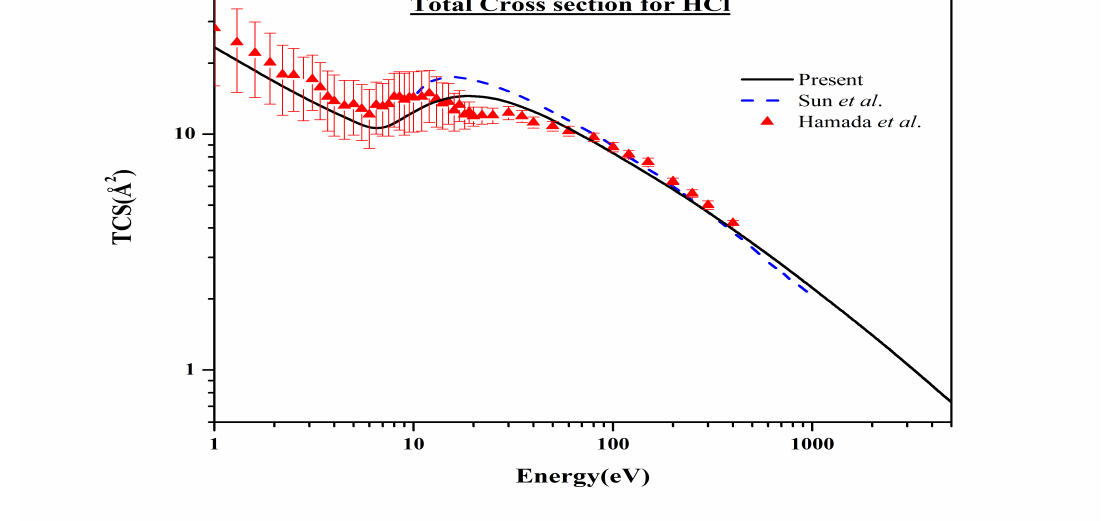
Figure 7. Total cross section for e + -HCl molecule interaction [50].